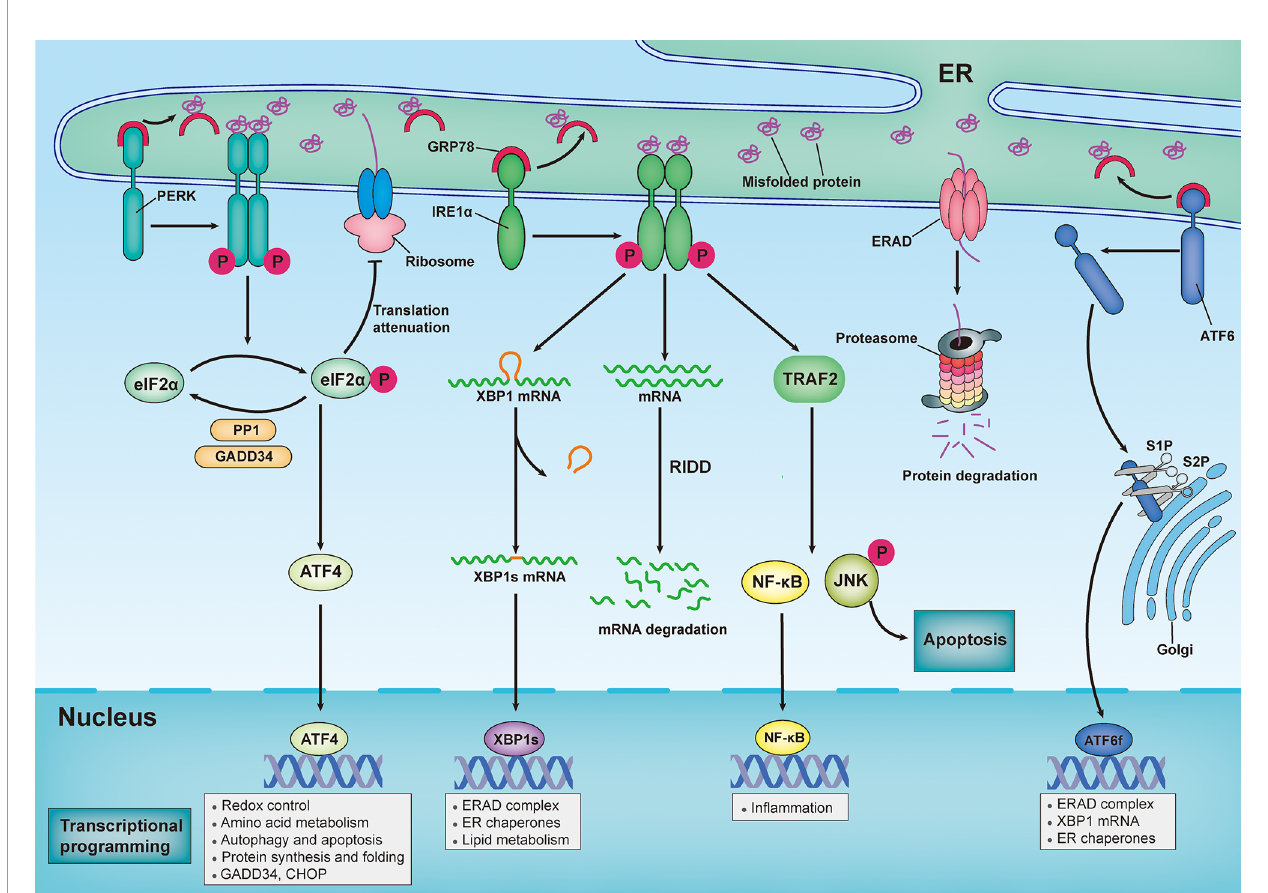
FIGURE 1 | Sensing and responding to endoplasmic reticulum stress: canonical roles of unfolded protein response. In response to an increasingly accumulation of misfolded proteins in endoplasmic reticulum (ER) lumen, three sensors that located in ER membrane — inositol-requiring enzyme 1 a (IRE1 a ), protein kinase RNA-like ER kinase (PERK) and activating transcription factor 6 (ATF6) — provoke unfolded protein response (UPR). Under homeostatic conditions, ER-resident protein chaperone glucose regulated protein 78 (GRP78) interacts with these ER stress sensors to restrain their activation. However, the excessive accumulation of misfolded proteins recruit GRP78 away from all three ER stress sensors, leading to activation of downstream signal transduction pathways. Upon ER stress, PERK undergoes its dimerization and autophosphorylation to phosphorylate eukaryotic translation initiator 2 a (eIF2 a ), which then selectively increases translation of activating transcription factor 4 (ATF4). ATF4 modulates the expression of genes involved in redox control, amino acid metabolism, autophagy, apoptosis, and protein synthesis and folding. Additionally, Phosphorylated eIF2 a (p-eIF2 a ) prevents ribosome assembly, which results in a translational block. Once ER stress is resolved, p-eIF2 a is dephosphorylated by the GADD34-protein phosphatase 1 (PP10) complex to restore protein translation. In response to ER stress, IRE1 a oligomerizes and promote autophosphorylation, eliciting RNase activity to splice the mRNA of x-box-binding protein 1 (XBP1). Spliced XBP1(XBP1s) mRNA codes for the functionally active proteins of XBP1s, which translocated into nuclear and subsequently induces the transcription of various genes that are involved in protein folding, lipid metabolism and ER-assisted protein degradation (ERAD). In addition, the RNase activity of IRE1 a can also degrades a subset of mRNAs in a process termed regulated IRE1 a -dependent decay (RIDD). By interacting with adaptor protein TNF receptor-associated factor 2 (TRAF2), IRE1 a can also activate c-Jun N- terminal kinase (JNK) and nuclear factor k B (NF- k B) pathways, thereby modulating in fl ammation and apoptosis. Upon ER stress, ATF6 is transported to Golgi, where it is cleaved by Site-1 protease (S1P) and Site-2 protease (S2P), releasing its active cytosolic fragment (ATF6f) that functions as a transcription factor. ATF6f induces genes required for ERAD and modulates the XBP1 mRNA levels and ER chaperone